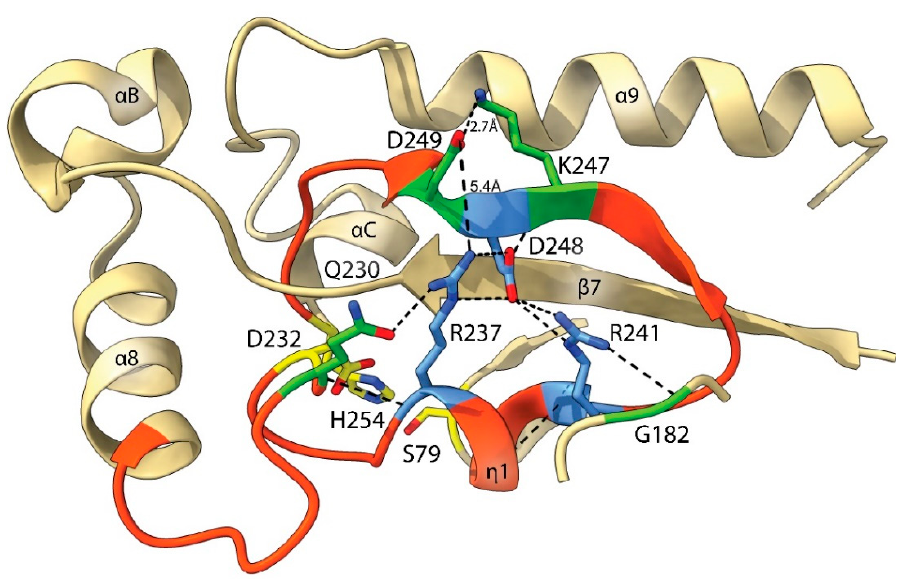
Figure 8. Enlarged view of the active-site region of PML. In addition to the ion pair formation with D248, R237 and R241 also form hydrogen bonds with Q230 and G182, respectively. S79, D232, and H254 are the catalytic residues.